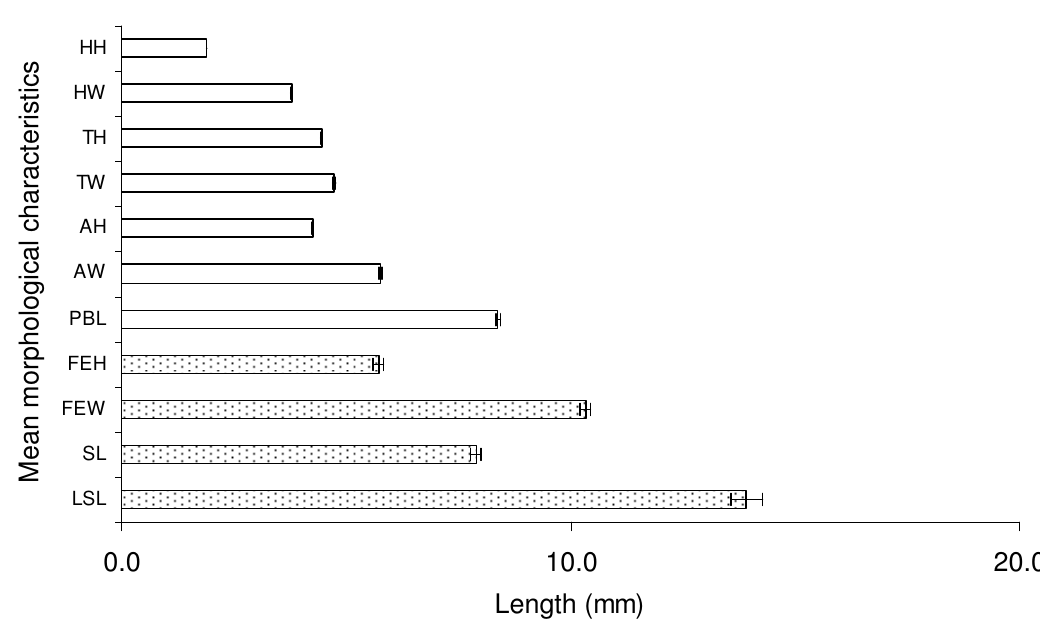
F IG . 4. Mean morphological characteristics of B. pascuorum individuals visiting female and male phase I. glandulifera flowers. B. pascuorum characteristics (open bars): head height (HH), head width (HW), thorax height (TH), thorax width (TW), abdomen height (AH), abdomen width (AW), proboscis length (PBL = prementum length + glossa length). Floral characteristics (dotted bars):